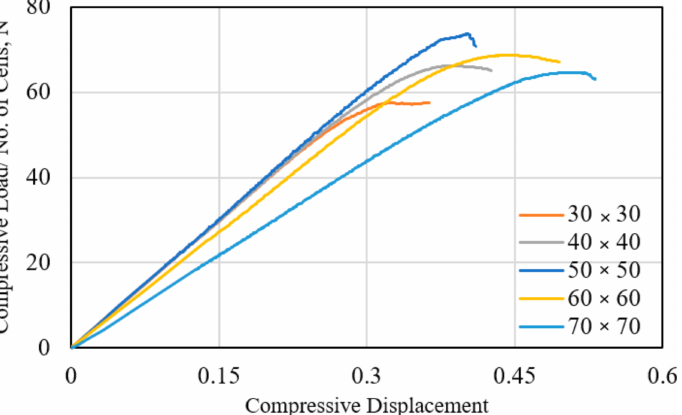
Figure 10. The measured compressive load–displacement responses of the HC core panel with a different cross-sectional area (cell size, c = 3.12; thickness, H = 12.7 mm).